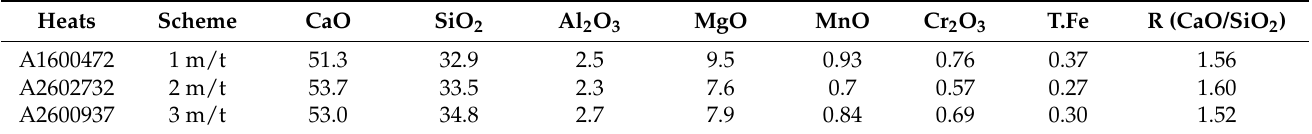
Table 6. Chemical composition of slag at end of LF refining (mass%).